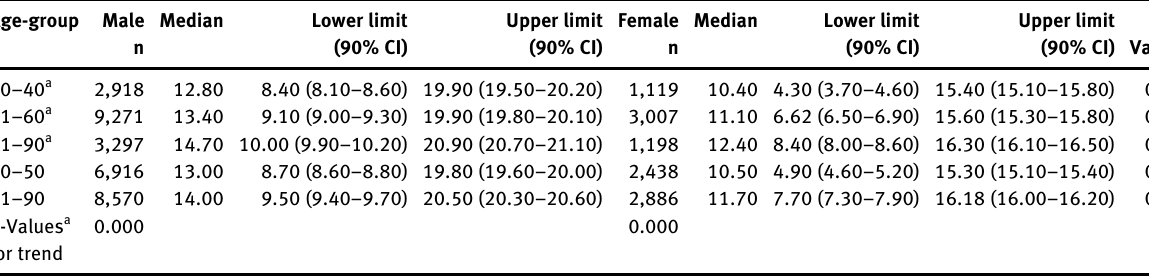
Table  : Reference intervals of Hcy for the different age-group and sex. Age-group Male